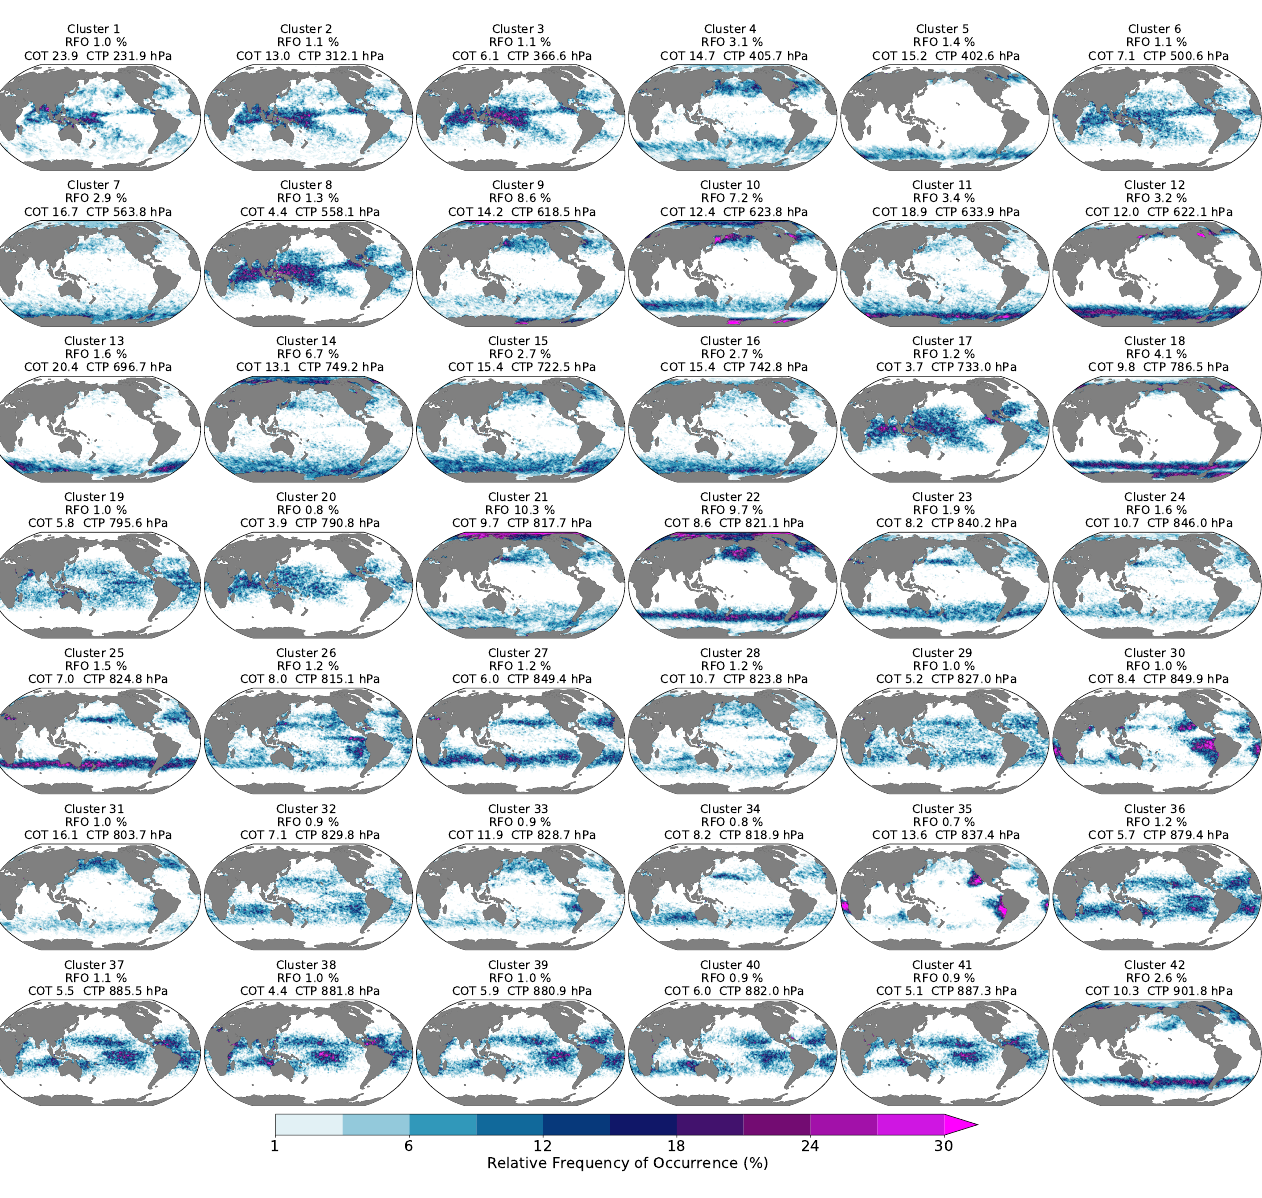
Figure 9. An example application of AICCA. We plot the relative frequency of occurrence (RFO) for each of the 42 AICCA 42 clusters, using all data from January and July, 2003. Land is in grey, and areas where RFO < 1.0% are in white. Surtitles show global mean RFO, cloud optical thickness (COT), and cloud top pressure (CTP) for the given cluster. Clusters show striking geographic distinctions, and those with roughly similar spatial patterns have different mean physical properties, suggesting meaningful physical distinctions. The 99 percentile of RFO values (RFO ≥ 1 %) of #30 is 29.85 % and the value of #35 is 36.58